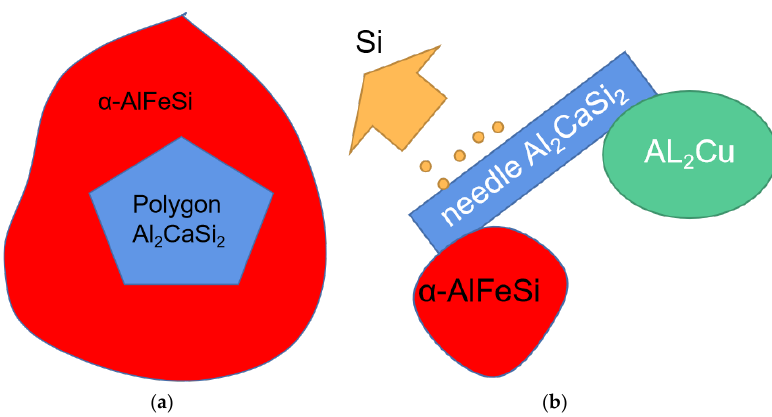
Figure 6. Relation of nucleation by ( a ) polygon- and ( b ) needle-shaped Al 2 CaSi 2.